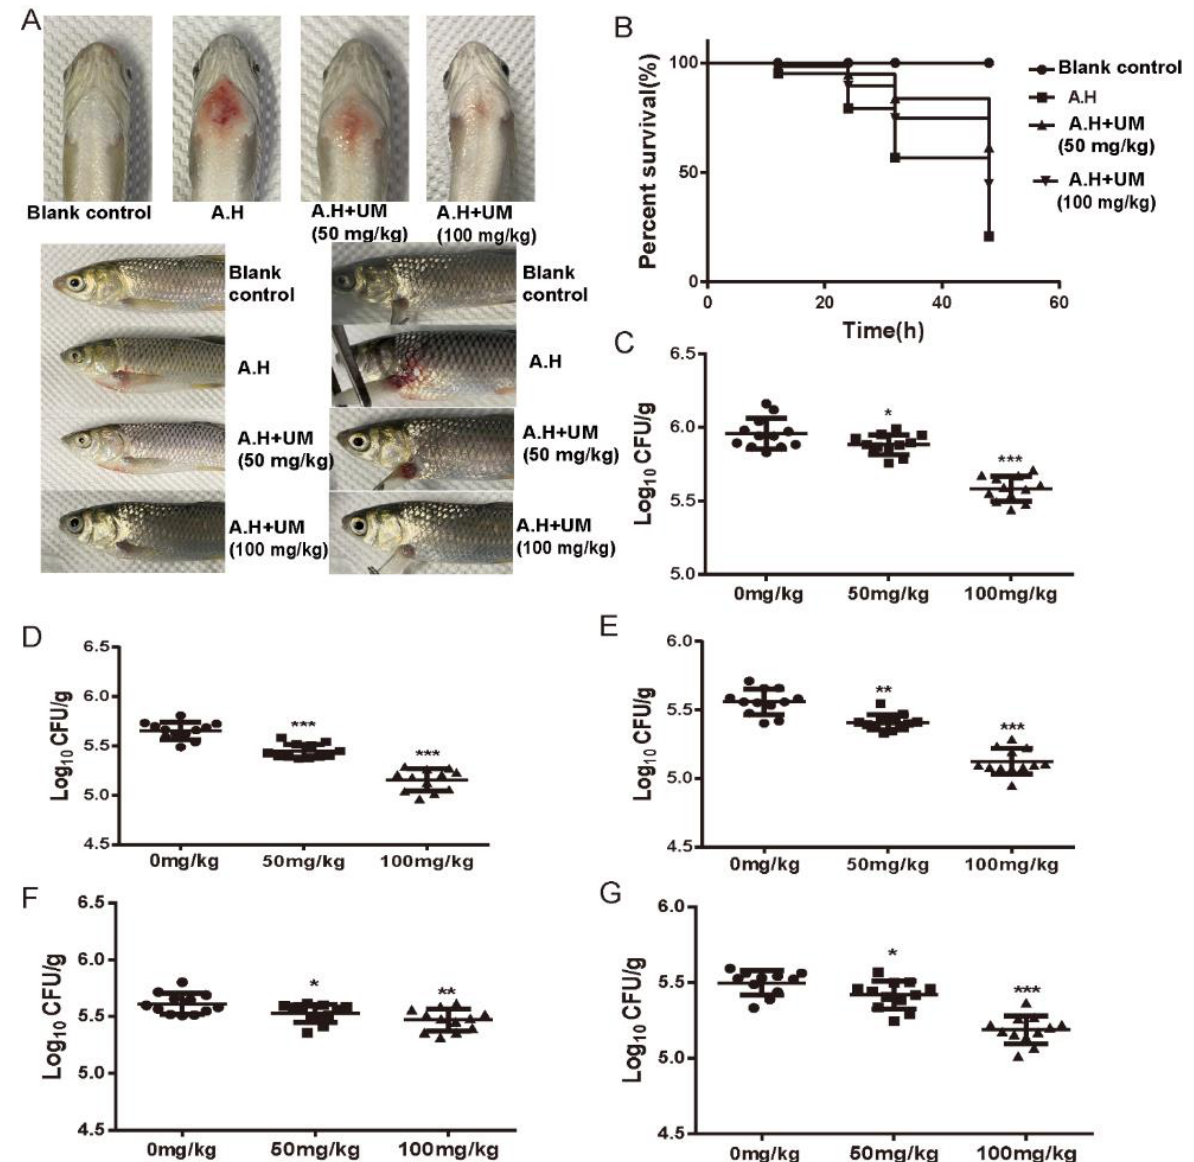
Figure 5. Protective effect of umbelliferone on grass carp infected with A. hydrophila . ( A ) Umbelliferone alleviates the symptoms of grass carps infected by A. hydrophila . ( B ) Umbelliferone increases the survival rate of grass carps infected with A. hydrophila . The bacterial load in ( C ) heart, ( D ) hepatopancreas, ( E ) spleen, ( F ) Mesonephros, and ( G ) Head kidney of grass carps with umbelliferone treatment decreased significantly. ***, p < 0.001; **, p < 0.01, *, p < 0.05, compared with the infection model group (0 mg/kg).